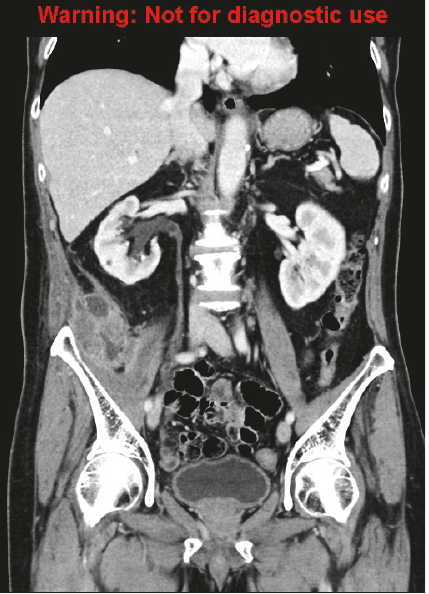
Figure 2: Coronal reconstruction demonstrating a persistent abscess in the retrocaecal region, with new extension to involve the pelvic side wall and iliopsoas muscles.